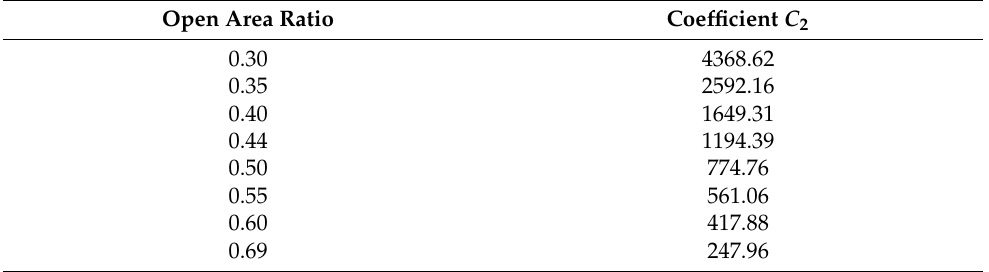
Table 5. Values of internal resistance coefficient C 2 .